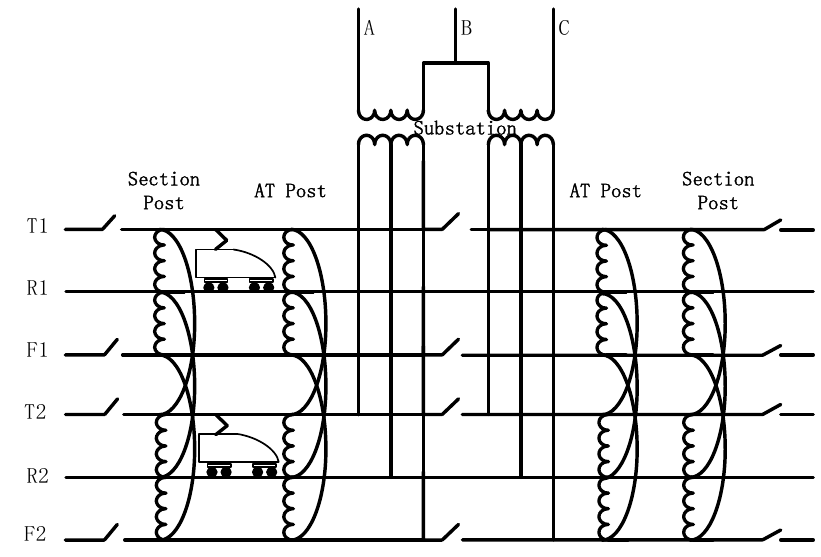
Figure 4. AT TPSS diagram.